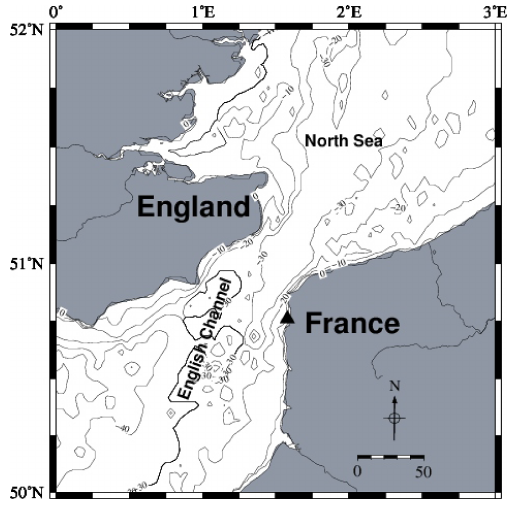
Figure 1. Location (black triangle) of the sampling station in the eastern English Channel together with the